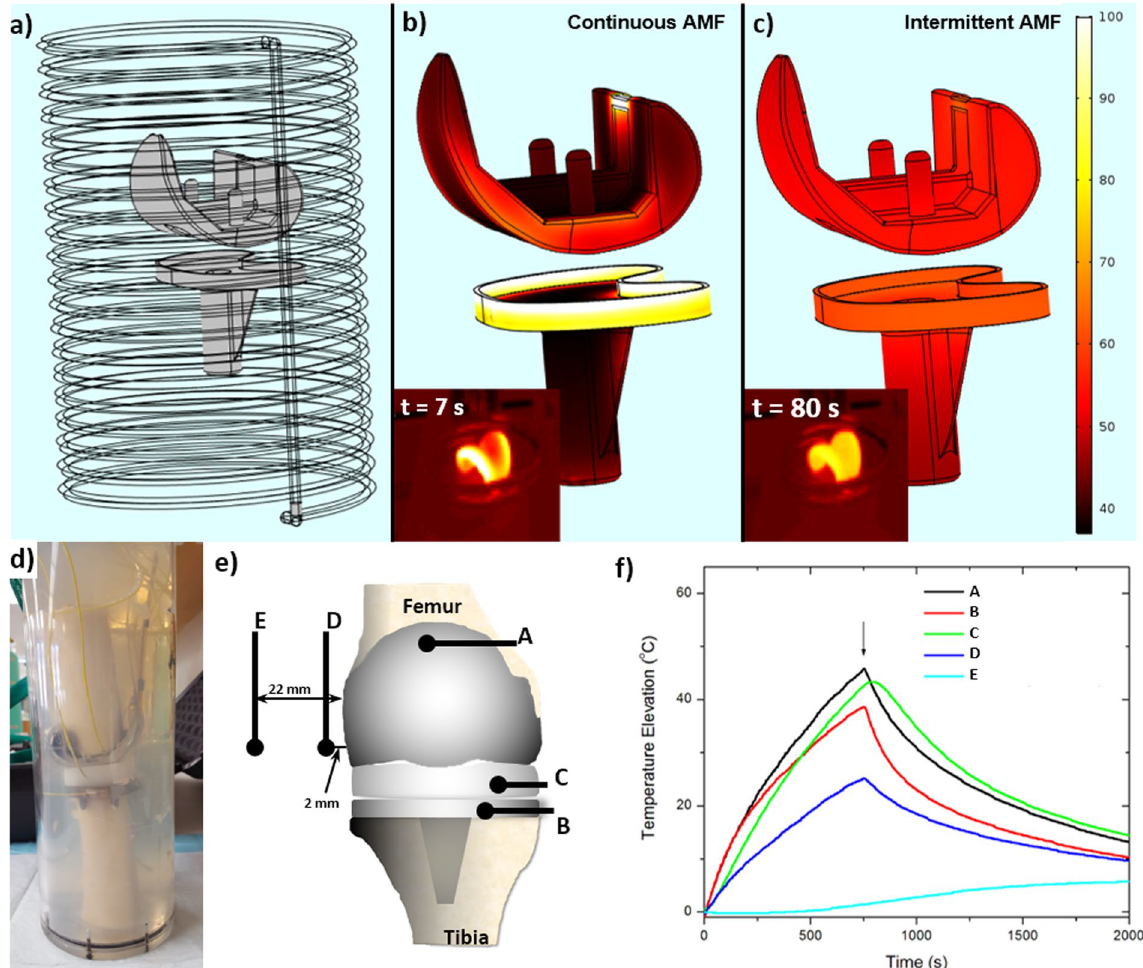
Figure 6. FEA modeling and experiments demonstrate an intermittent AMF exposure can achieve uniform heating across the surface of a prosthetic knee implant. ( a ) Using COMSOL ® a 3D representation of a prosthetic knee implant inside a solenoid coil can be defined. ( b ) The surface temperature distribution after 3 seconds of continuous 600W AMF exposure is very non-uniform (over 60 °C range across surface). ( c ) Using an intermittent AMF exposure (1500W for 1 second, every 50 seconds) a uniform surface temperature distribution is achieved after 1200 seconds (20 exposures). The infrared images of the femoral component of a knee prosthesis exposed to AMF (insets of b) and c)) depict the different surface temperature distributions between continuous and intermittent exposures. ( d ) A prosthetic knee implant was embedded in a phantom composed of bovine bone and muscle-equivalent gel material. ( e ) Fiber-optic temperature sensors were embedded in the phantom at the locations shown in the schematic. ( f ) Temperatures recorded over time during an intermittent AMF exposure (300 ms in duration, applied every 15 seconds) demonstrate that after 10 minutes, the top, middle and bottom surfaces were within a few degrees of each other, and were elevated approximately 40 °C above baseline. Further, while the tissue 2mm from the implant is elevated approximately 20 °C above baseline, tissues 22 mm from the implant only experience a temperature elevation of a few degrees C. Movies of the simulations in b) and c) are included as supplemental